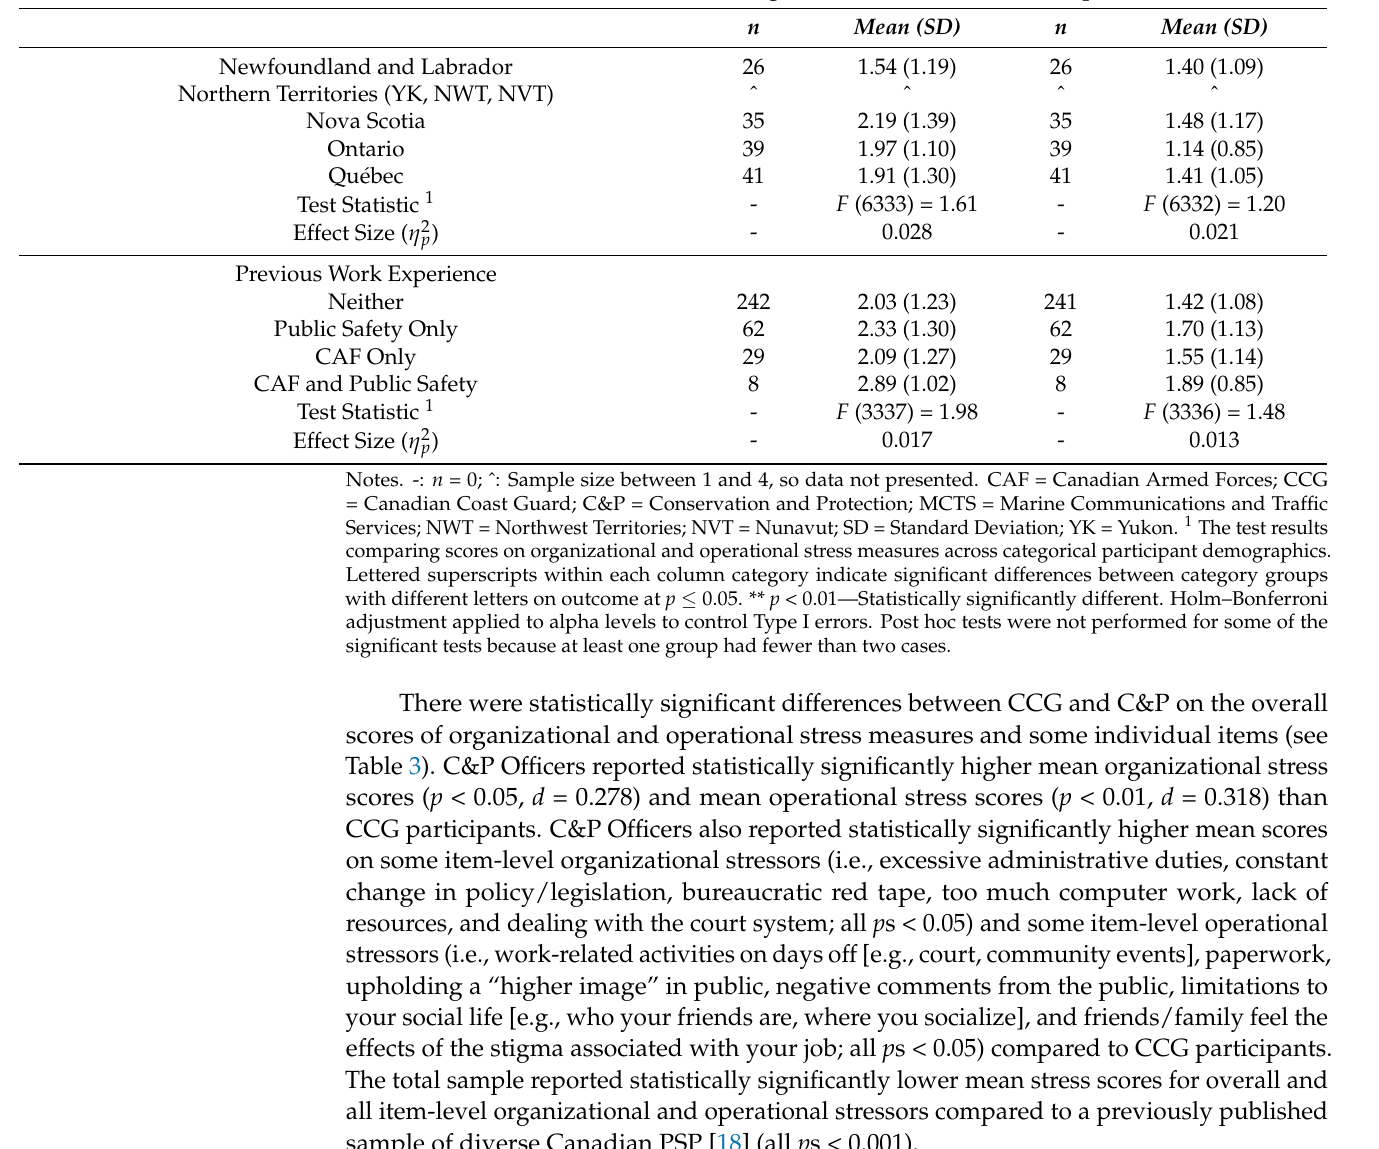
Organizational Stressors Operational